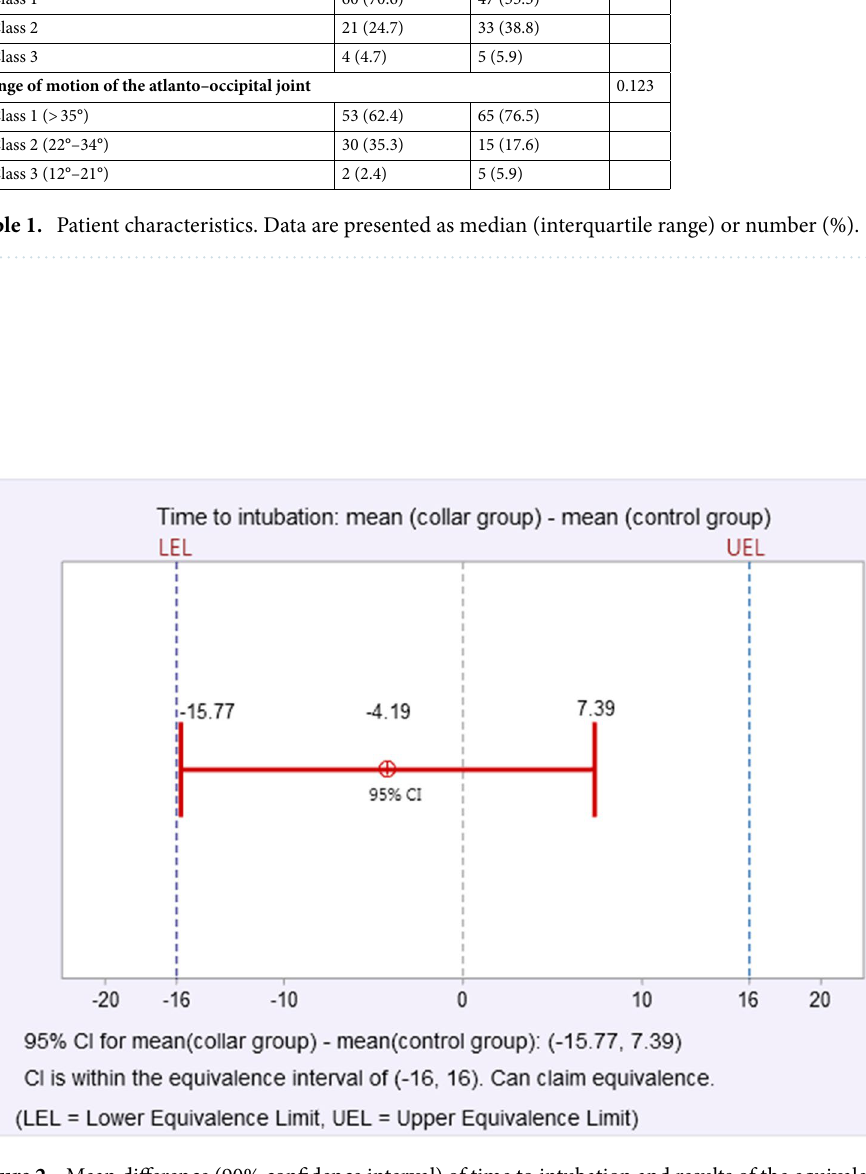
Figure 2. Mean difference (90% confidence interval) of time to intubation and results of the equivalence test of means after two one-sided